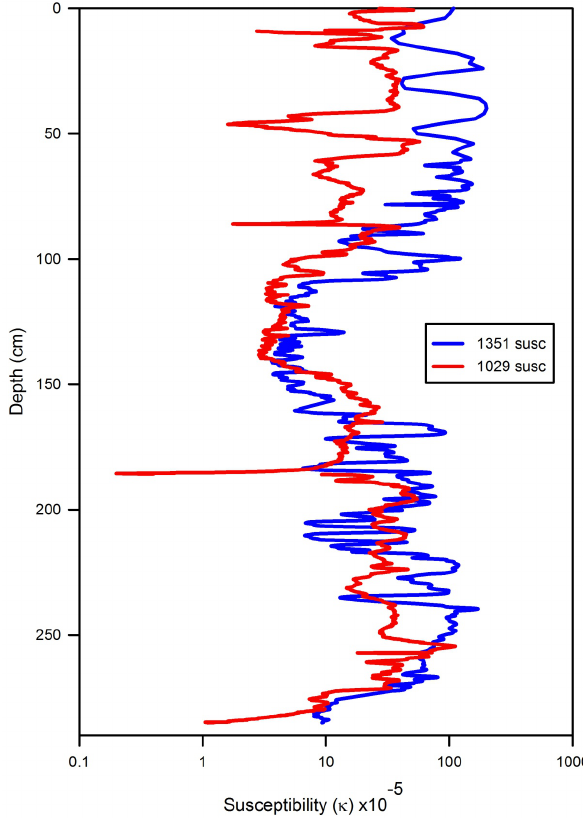
Fig. 4. Comparison of susceptibility ( κ) between PG1351 (Nowaczyk, et al., 2002, 2007) and LZ1029.